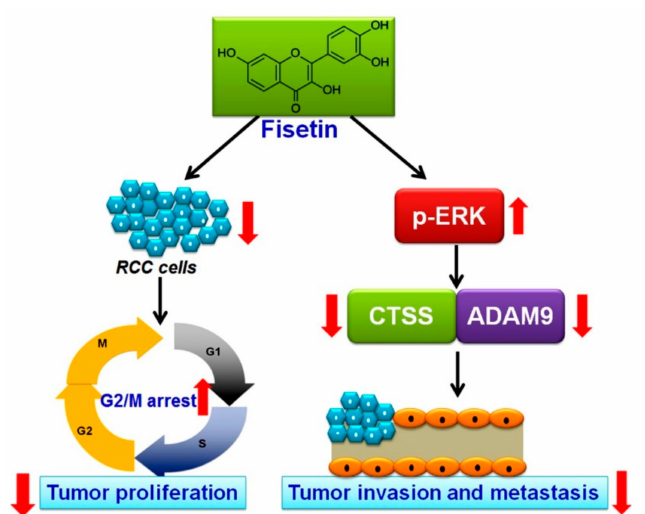
Figure 8. Schematic representation of the antiproliferative and antimetastatic e ff ects of fisetin in human RCC cells. Fisetin has antiproliferative and antimetastatic e ff ects on human RCC cells mediated by the downregulation of CTSS and ADAM9 through the ERK signaling